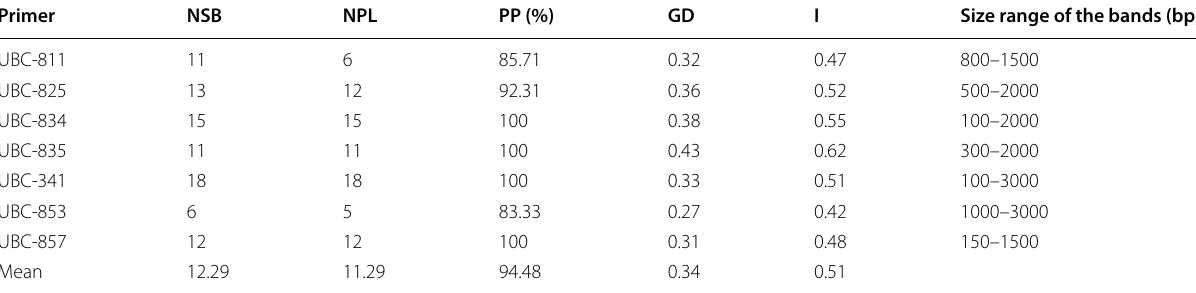
NSB number of scorable bands, NPL number of polymorphic loci, PP percent of polymorphism, GD genetic diversity, I Shannon’s information index